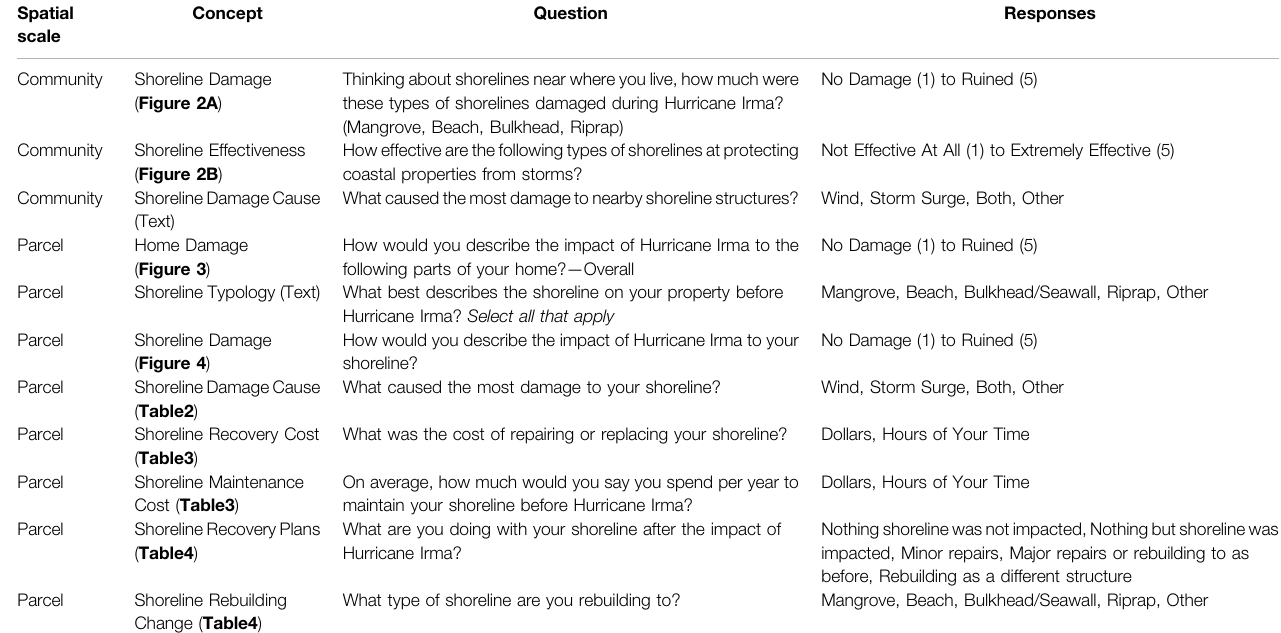
TABLE 1 | Survey questions used for measuring impacts of Hurricane Irma. The corresponding fi gure or table showing the results of the survey questions are in bold. Spatial